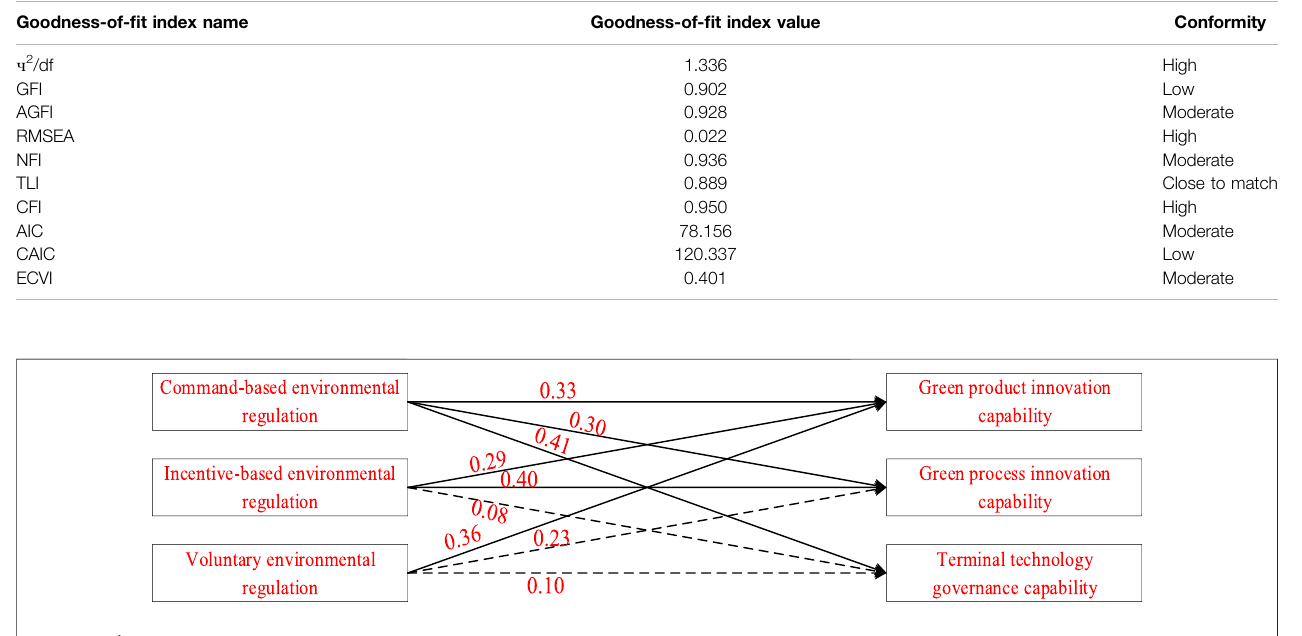
FIGURE 2 | Model test